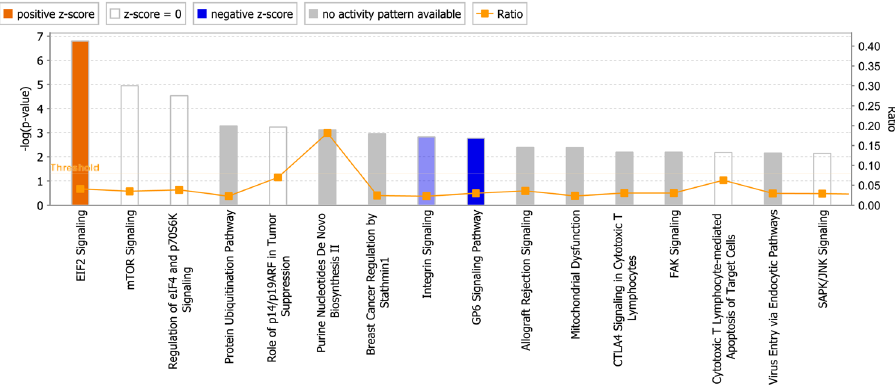
Figure 3. Canonical pathways varied in Group 2. Orange indicates an “activated” canonical pathway, while blue means “inactivated”. White: activation not predictable in any particular direction, grey: not covered for predictive function, Ratio: ratio of the molecules examined to those that are already